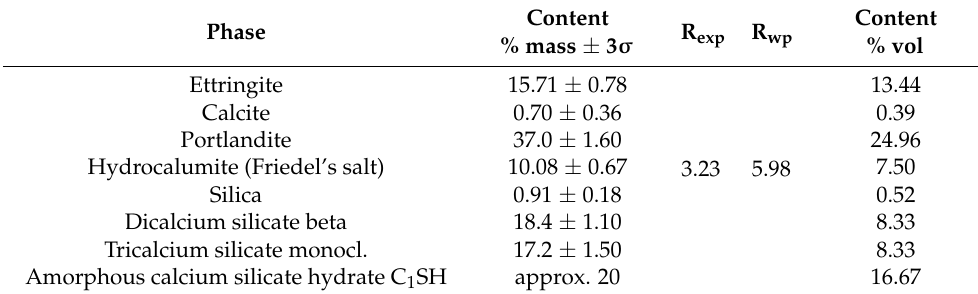
Table 5. Phase composition of hardened cement paste—C.I.3. specimen.